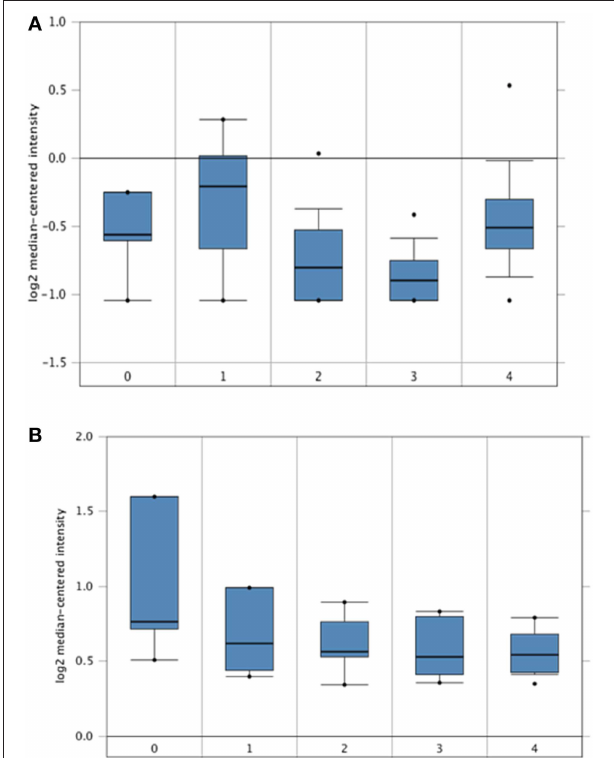
FIGURE 1 | In silico analyses of SP-D (SFTPD) expression in different subsets of ovarian cancer patients. SP-D gene expression from the Hendrix et al. (31) dataset plotted by Oncomine. (A) Mean SP-D gene expression in control normal ovaries (0), ovarian clear cell adenocarcinoma (1), ovarian endometrioid adenocarcinoma (2), ovarian mucinous adenocarcinoma (3), and ovarian serous adenocarcinoma (4). Boxes represent the 25th-75th percentile (with median line), bars show the 10th − 90th percentile and dots show the complete spread of data. Fold change in SP-D expression was 1: 1.217 ( p = 0.123), 2: − 1.109 ( p = 0.782), 3: − 1.201 ( p = 0.897) and 4: 1.086 ( p = 0.266) when compared to normal, respectively. SP-D gene expression from the Lu et al. dataset (B) . Mean SP-D gene expression in control normal ovaries (0), ovarian clear cell adenocarcinoma (1), ovarian endometrioid adenocarcinoma (2), ovarian mucinous adenocarcinoma (3), and ovarian serous adenocarcinoma (4). Fold change in SP-D expression was 1: − 1.179 ( p = 0.855), 2: − 1.214 ( p = 0.893), 3: − 1.255 ( p = 0.922) and 4: − 1.257 ( p = 0.924) when compared to normal,